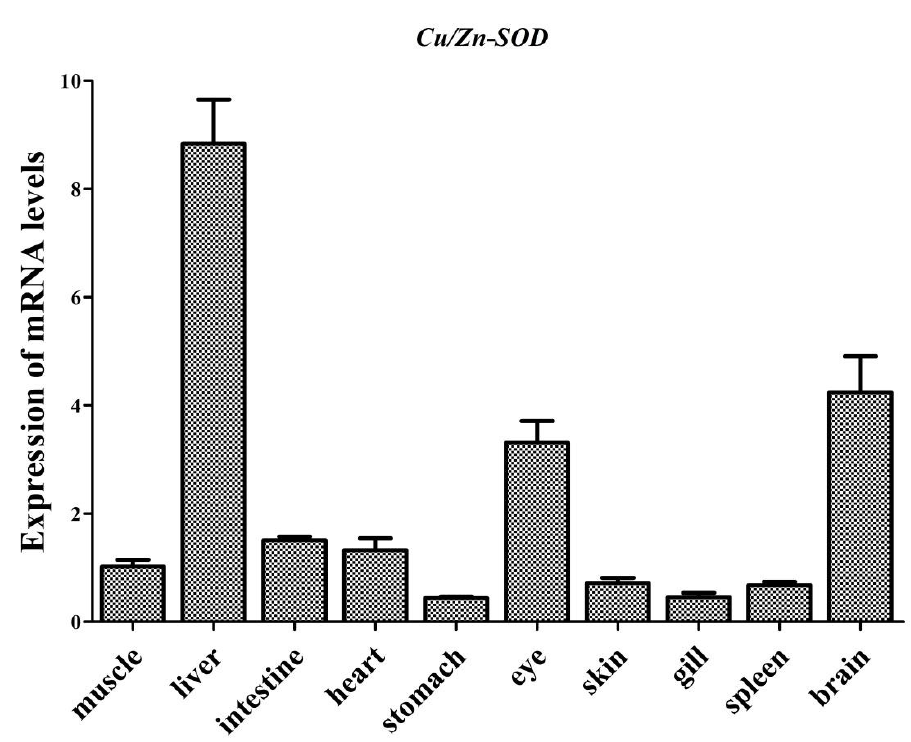
Figure 6. Distribution of AdCu/Zn-SOD gene expression in different tissues of Yangtze sturgeon.